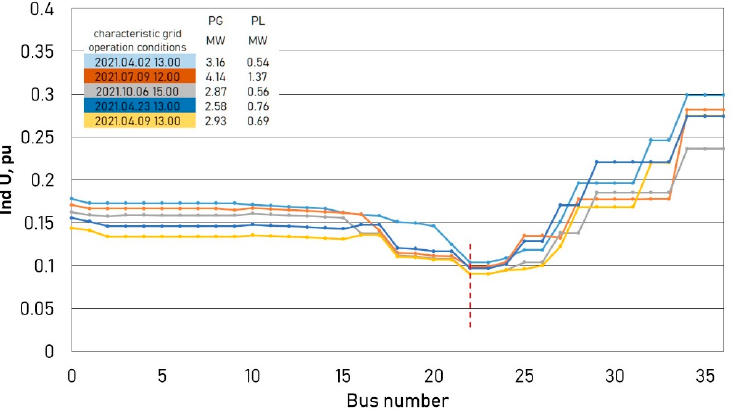
Figure 16. The results of simulations determining the voltage quality index for five characteristic grid operation conditions depending on the selection of the reference node.